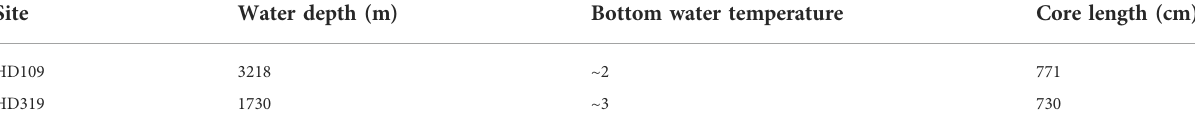
TABLE 1 Location of the studied